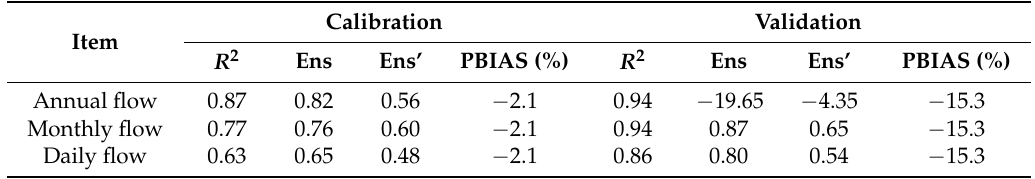
Table 2. Calculated statistical parameters of model performance for streamflow calibration/validation. Calibration Validation Item